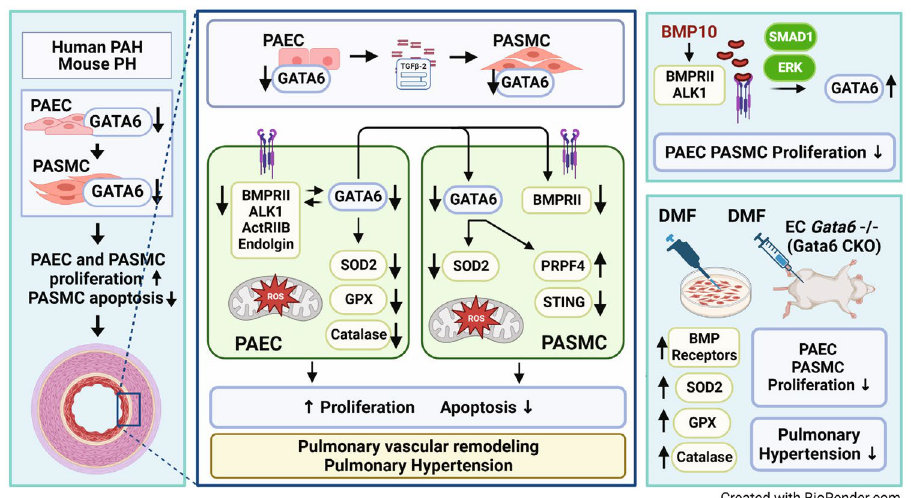
Figure 8. Graphical representation of the role of GATA6 in coordinating cross-talk between BMP10 and oxidative stress axis in PAH. GATA6 is an activator of anti-oxidant enzymes and its deficiency in PAEC and PASMC induces oxidative stress and mitochondrial dysfunction. BMP10 induces expression of GATA6 through the ALK1, BMPRII, ENG and ERK pathway. GATA6, in turn, transcriptionally activates BMP receptors in PAEC. Endothelial GATA6 regulates PASMC function via paracrine factors. TGFβ2 secreted by GATA6 deficient PAEC induces PASMC proliferation. Administration of dimethyl fumarate (DMF) to mice with endothelial Gata6 loss restores expression of BMP receptors, resolves oxidative stress, and reverses